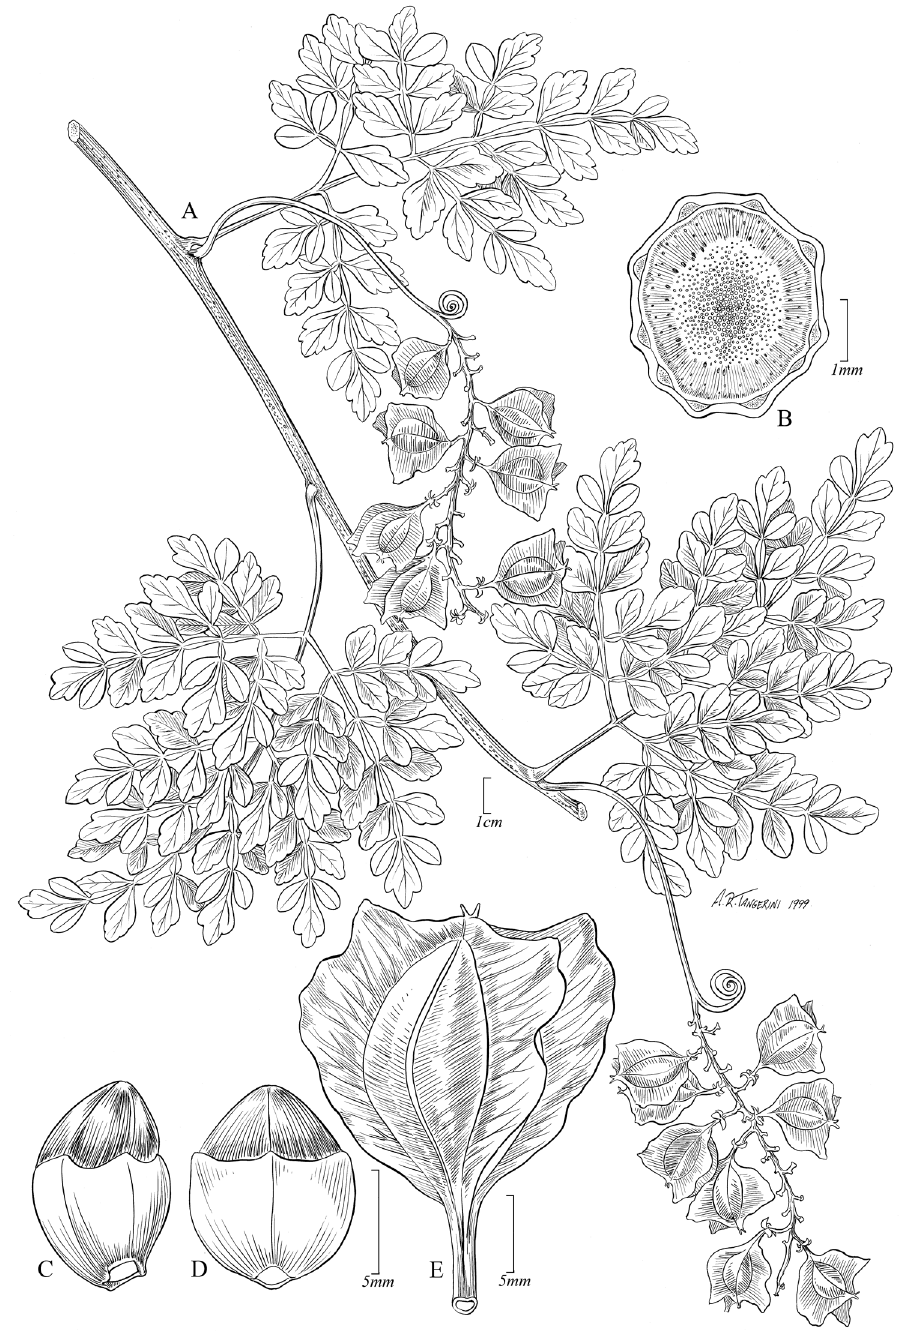
Figure 4. Paullinia hondurensis . A Fruiting branch B Detail of cross section of stem C Seed, lateral view D Seed, frontal view E Fruit. All from Thomas et al. 139